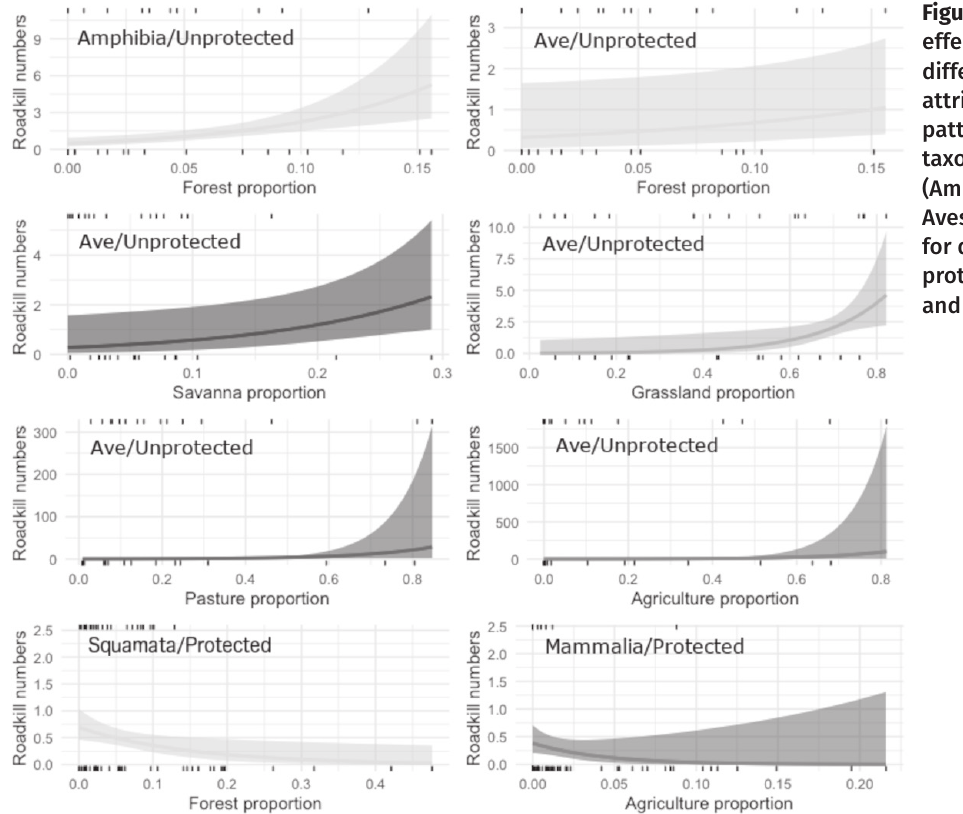
Figure 5. Significant effects found of different landscape attributes on roadkill patterns of each taxonomic group (Amphibia, Squamata, Aves, and Mammalia) for different levels of protection (protected and unprotected).